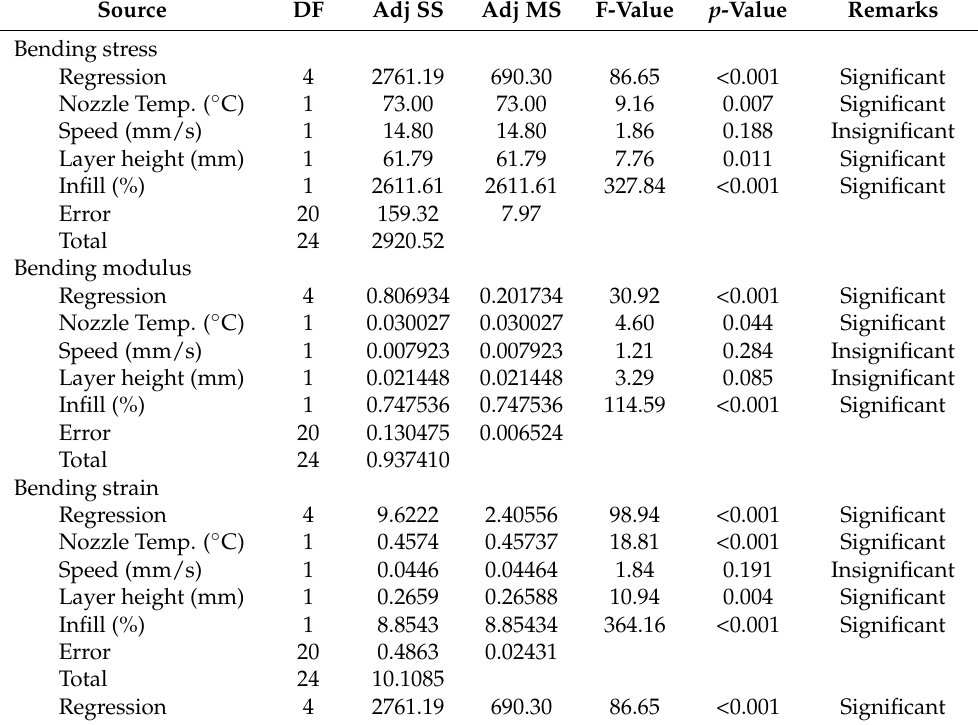
Table 7. ANOVA analysis for PETG.